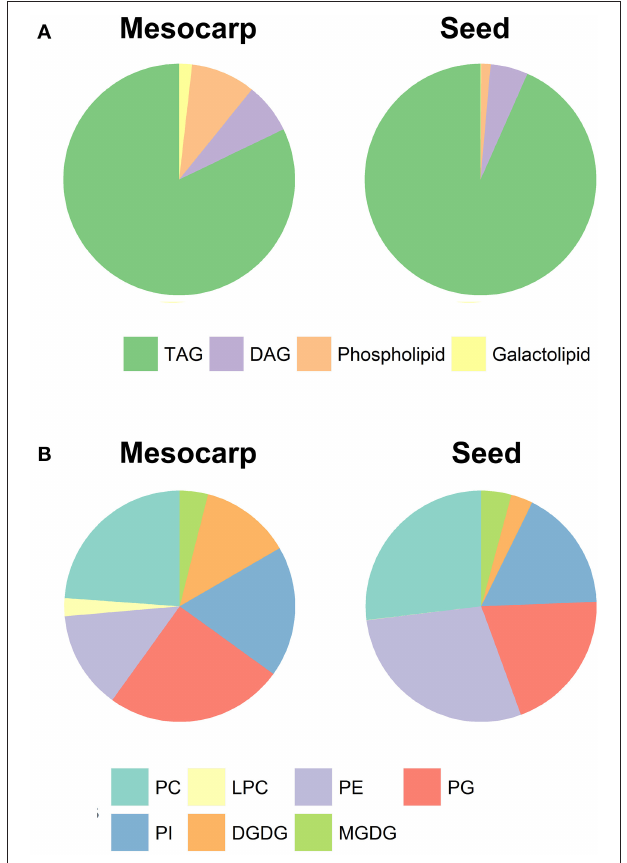
FIGURE 3 | The composition of total (A) and polar (B) lipids in Triadica sebifera LD isolated from stage III immature mesocarp and seed kernel.